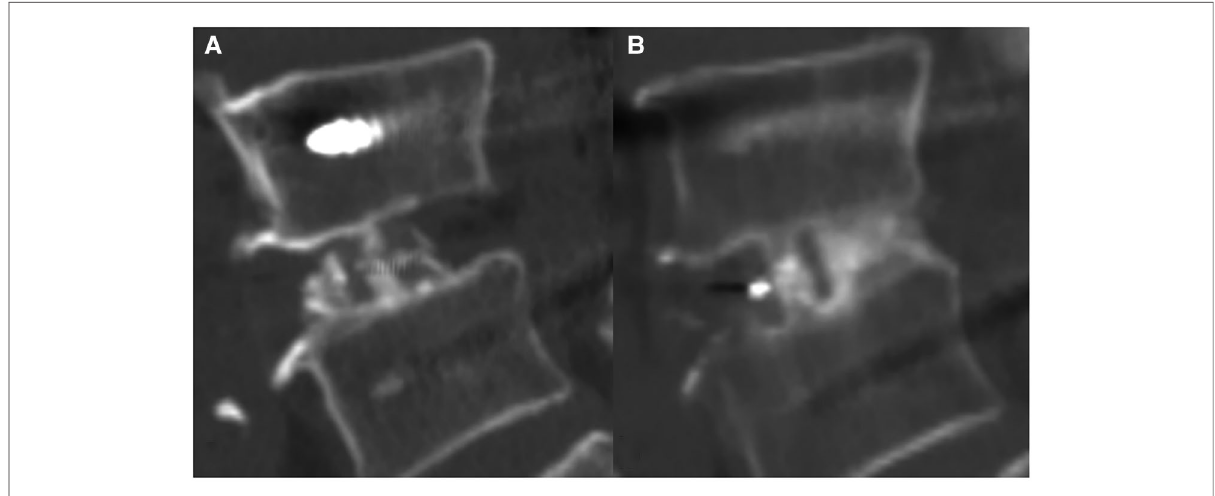
FIGURE 2 A 71-year-old Male patient received cage implantation after surgery for lumbar spinal stenosis. ( A ) Sagittal lumbar CT scan performed at postoperative 3 days revealed good bone fi lling in the inner cage zone but no bone graft in the posterior cage zone. ( B ) CT at postoperative 3 years showed bone remodelling and passage of the bone trabecula in the inner cage zone and the posterior cage